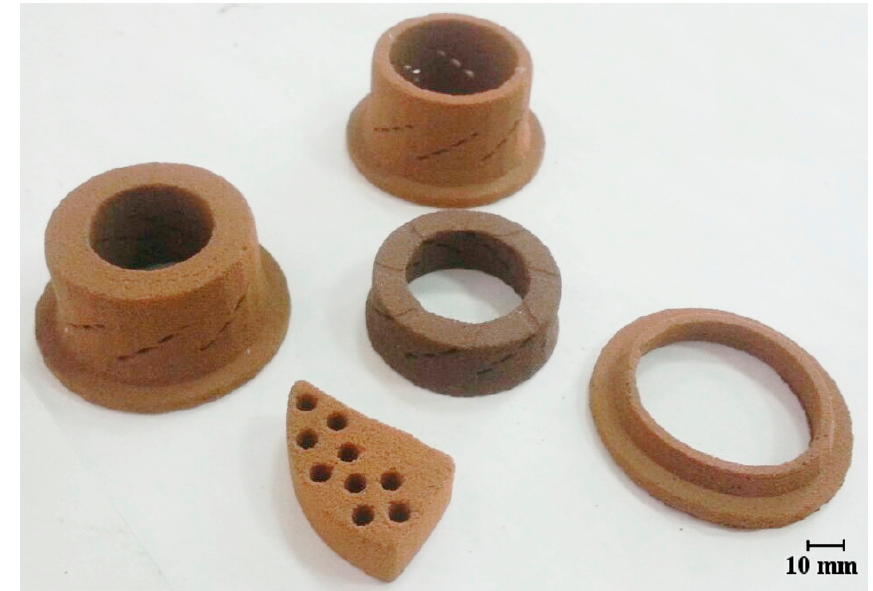
Figure 11. Produced test 3D parts from the PEEK. Table 1. Comparison of mechanical properties.